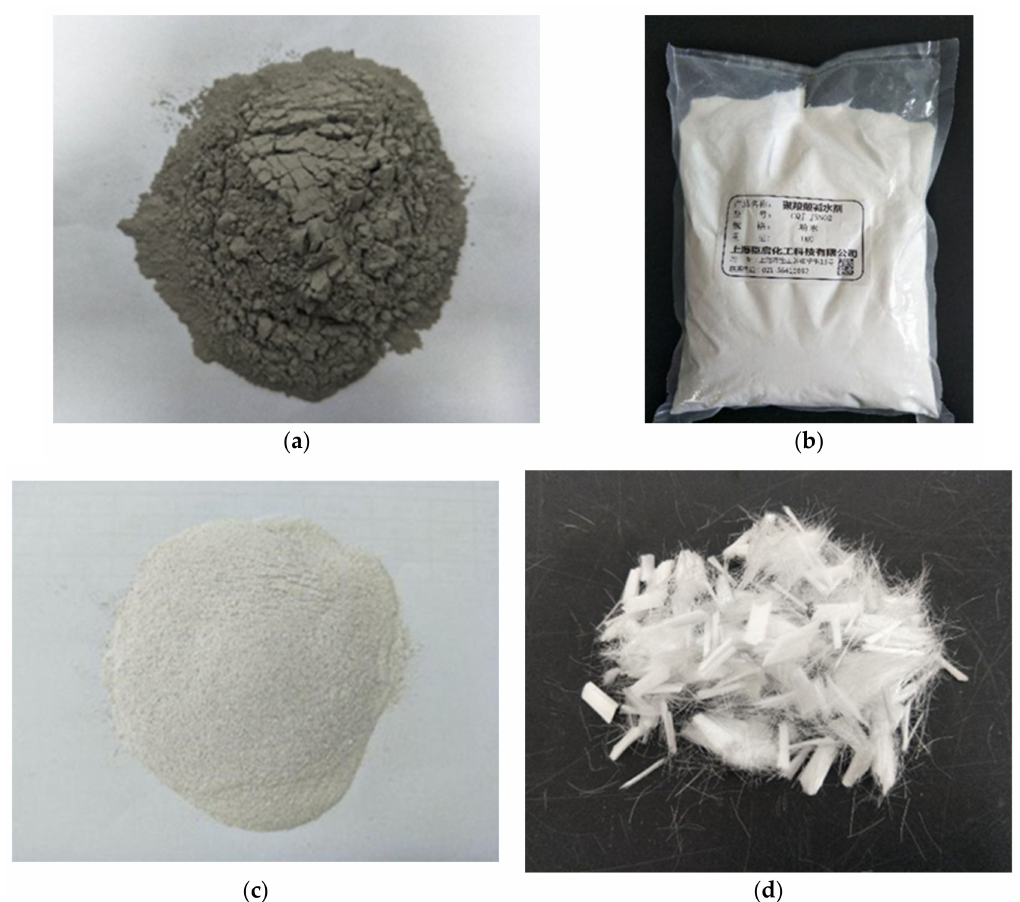
Figure 3. Main materials used in this paper. ( a ) Fly ash; ( b ) polycarboxylate superplasticizer; ( c ) cementitious capillary crystalline active masterbatch; ( d ) polypropylene